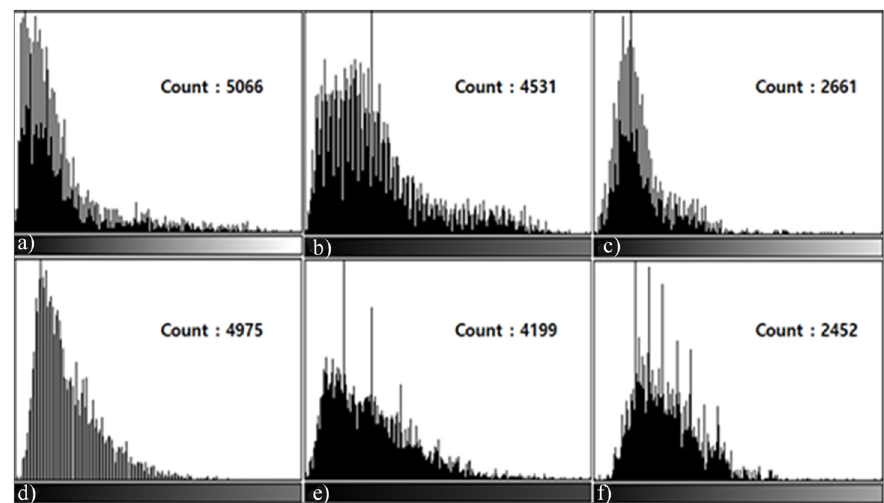
Figure 3. L3, L4 Histogram values measured in the T1 Sagittal Image of Pig L-spine Phantom. When the distribution value was measured in the T1 Sagittal Image at the 6th section, the value was higher in T1 STIR than in T1 CS-SEMAC (SPIR) value, and the signal loss was also higher. T1 STIR Histo- gram ( a , d ); T1 mDixon (O-MAR) Histogram ( b , e ); and T1 CS-SEMAC (SPIR) Histogram ( c , f ).